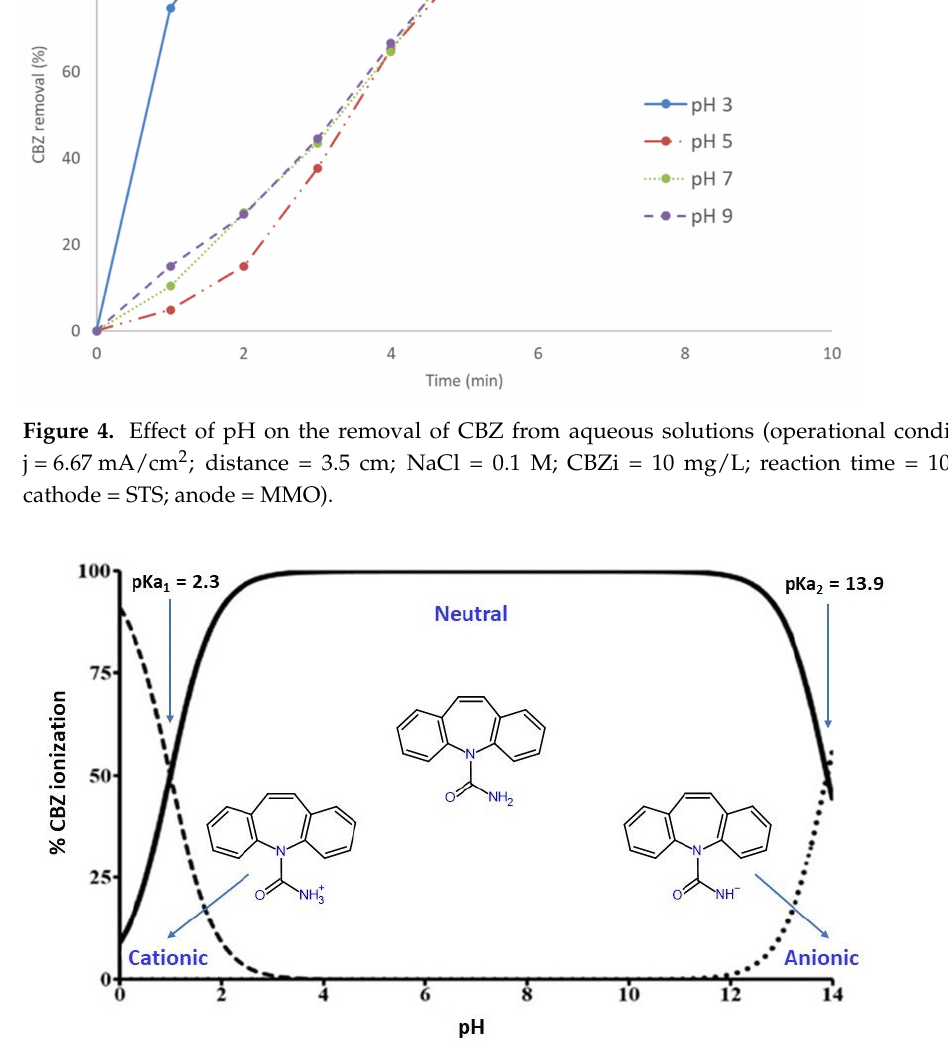
Figure 5. Speciation of CBZ as a function of the pH of the aqueous solution (adapted from